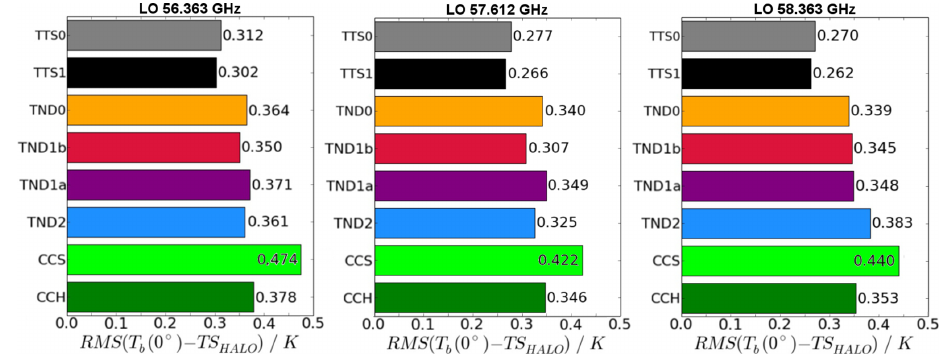
Figure 11. The rms difference between HALO TS and TBs derived from the MTP measurement signal at a limb-viewing angle of 0 ◦ at the three standard frequency channels during all ML CIRRUS flight segments with no altitude changes, curves, or ND failures with signals longer than 10min. Refer to Table 6 for the denominations of the calibration